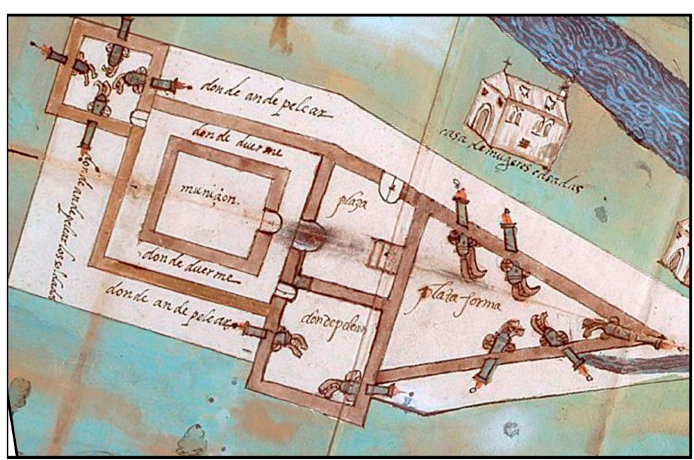
Figure 15. A composite magnetic gradiometry and GPR map ( top ) of the architecture of San Marcos (I) accompanied by an historic map of the layout of San Marcos (I) ( bottom ).